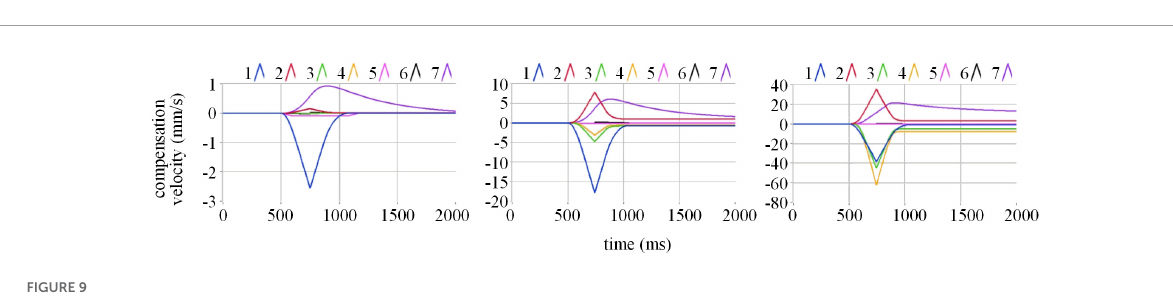
FIGURE9 Components of the compensation